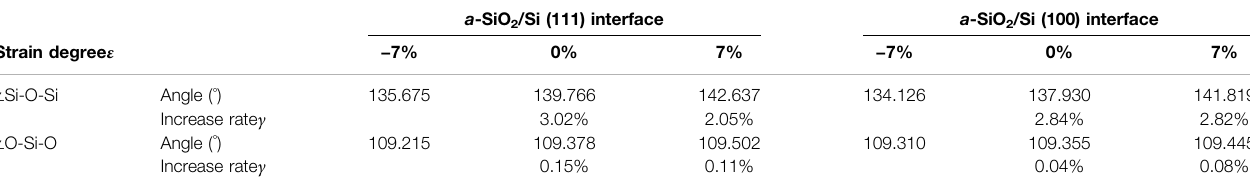
TABLE 6 | The average angles and increase rates of ∠ O-Si-O and ∠ Si-O-Si at different